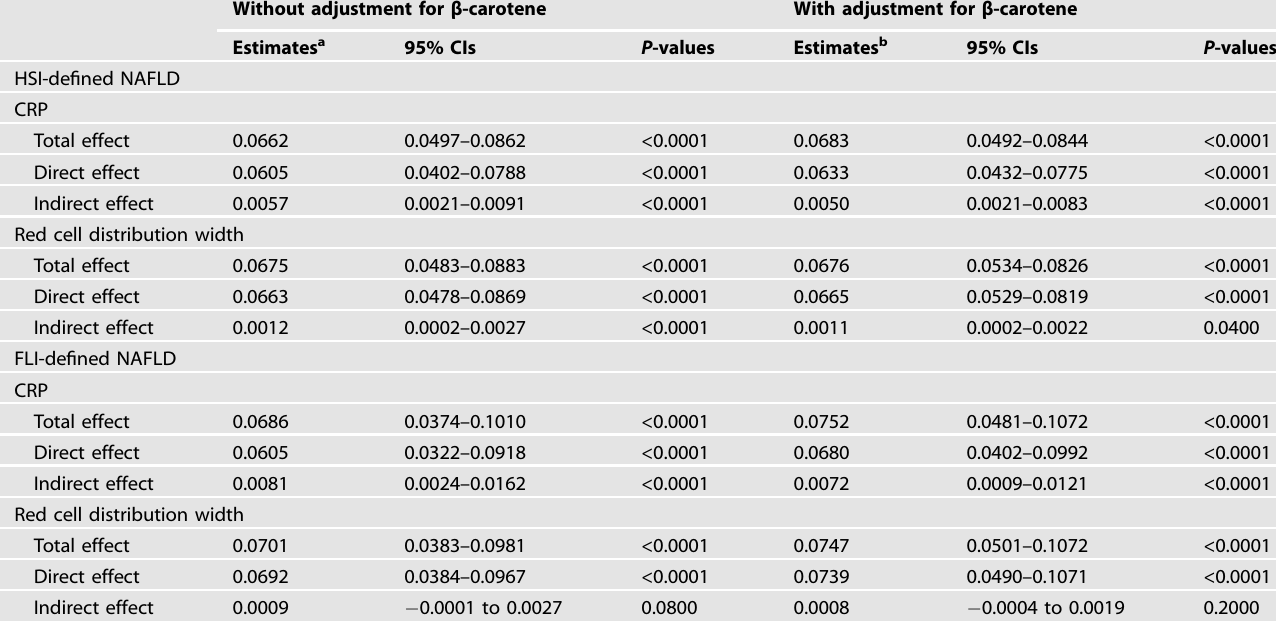
Table 3. Mediation effects of dietary sodium on NAFLD with CRP and red cell distribution width as mediators. Without adjustment for β